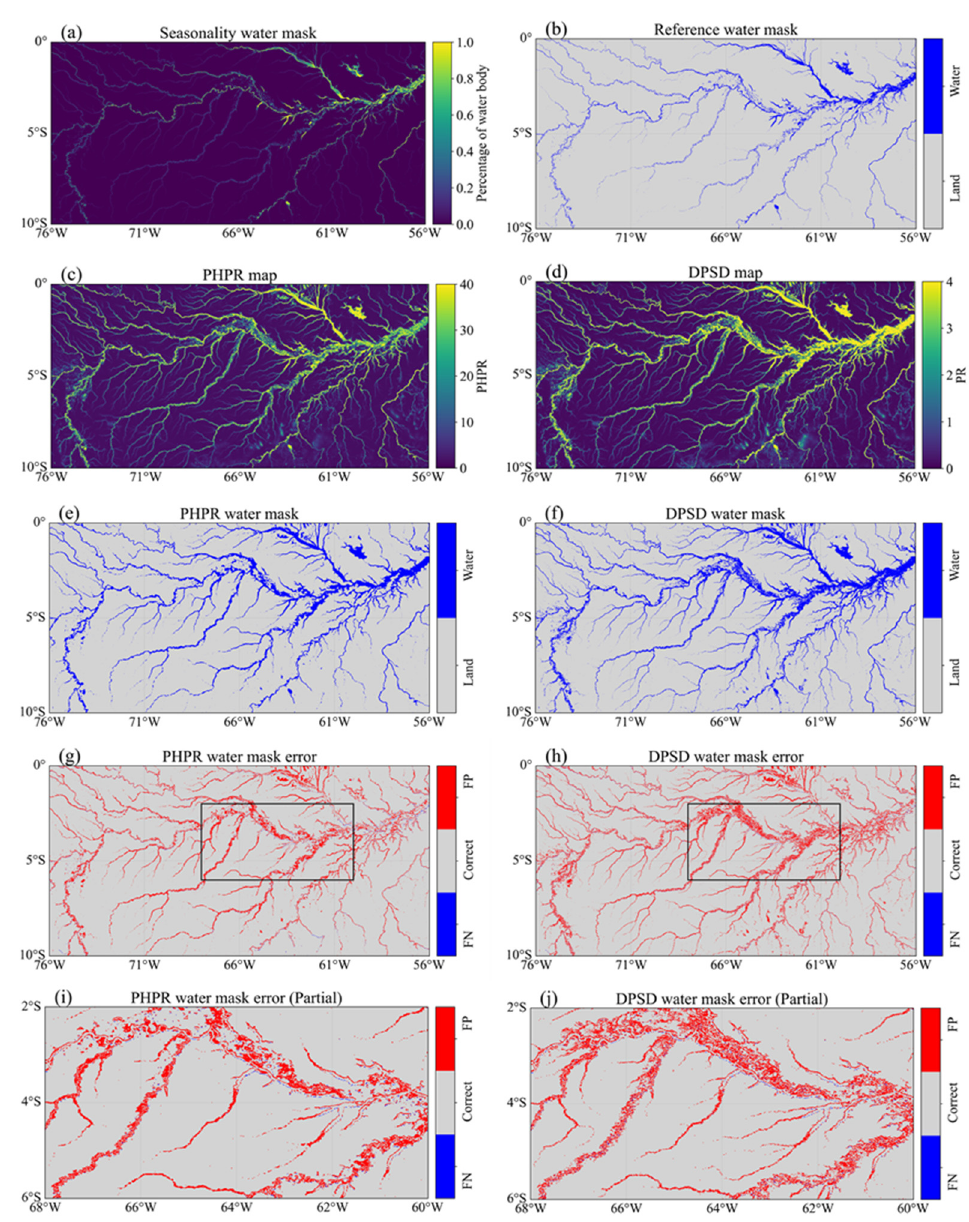
Figure 10. Amazon Basin maps. ( a ) Seasonality water map in 2020 derived from GSW; ( b ) GSW water mask ( c , d ) DPSD and PHPR maps; ( e , f ) water mask obtained from DPSD and PHRP result maps; ( g , h ) error maps obtained by DPSD and PHPR methods; ( i , j ) enlarged views of the PHPR and DPSD water mask error maps for the specified area indicated by the black rectangles in ( g , h ), respectively.